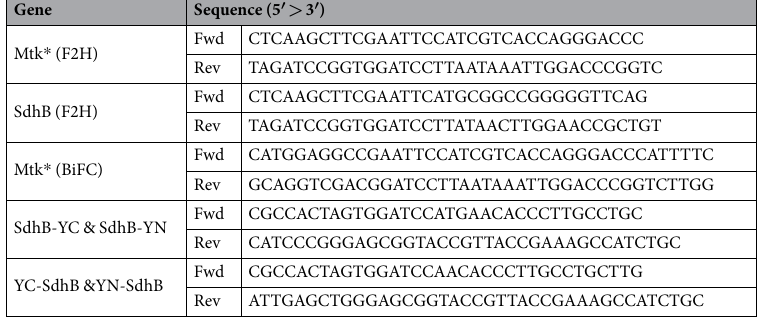
Table 1. Primer sequences used in this study. * We used the HRH isoform of Mtk in this